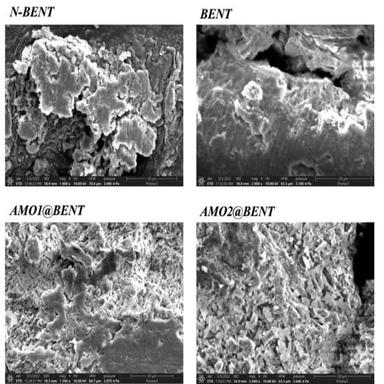
SEM images of N-BENT, BENT, AMO1@BENT and AMO2@BENT samples.